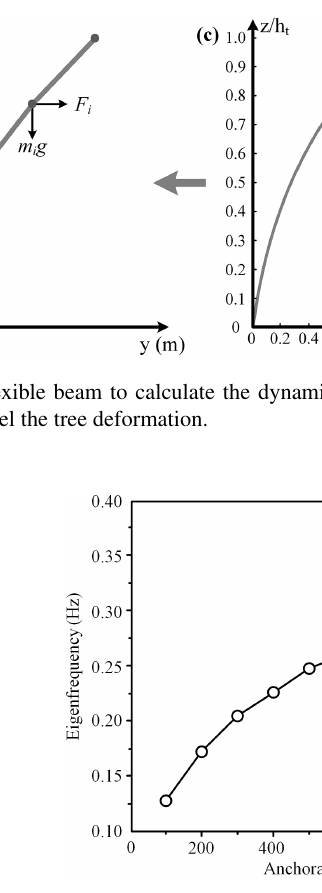
Figure 4. Eigenfrequency of trees corresponding to different an- chorage